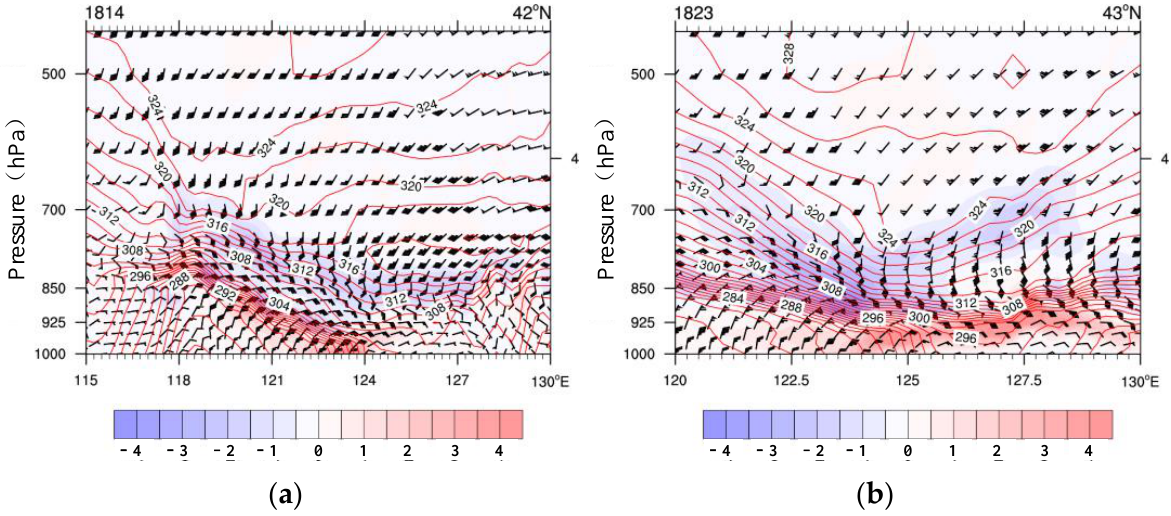
Figure 6. ( a ) the altitude and longitude profile of the false equivalent potential temperature (isoline), the second term of wet potential vorticity (color) and the wind field along 42 ◦ N at 14:00 on 18 November, ( b ) the altitude and longitude profile of the false equivalent potential temperature (isoline), the second term of wet potential vorticity (color) and the wind field along 43 ◦ N at 23:00 on 18 November.